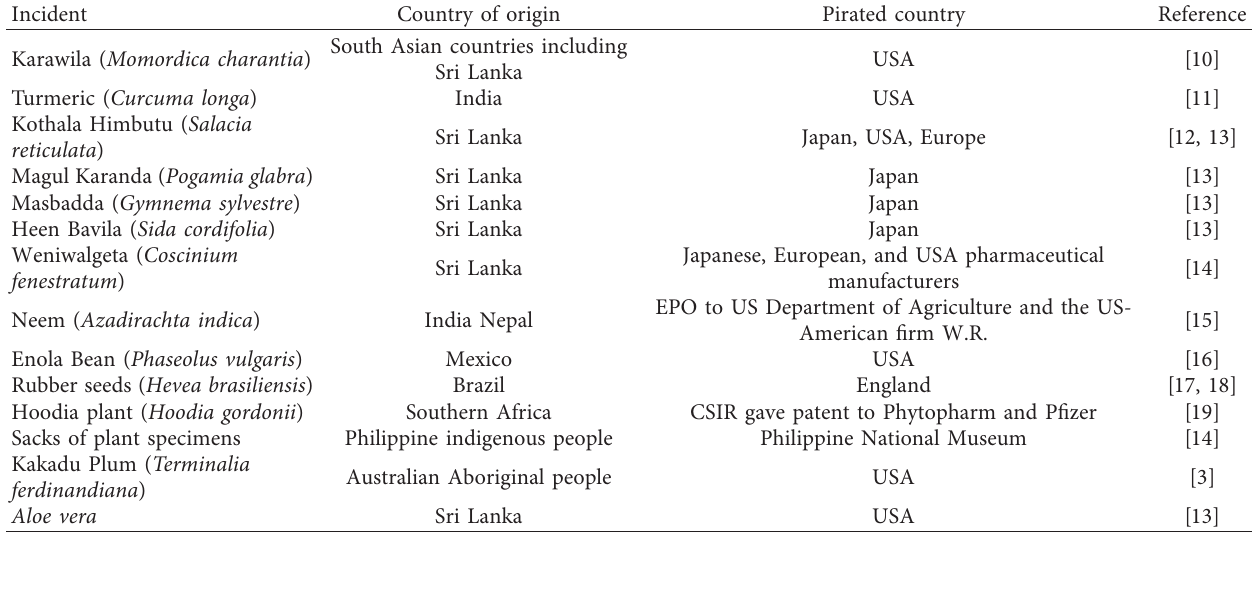
Table 1: Global biopiracy incidents with